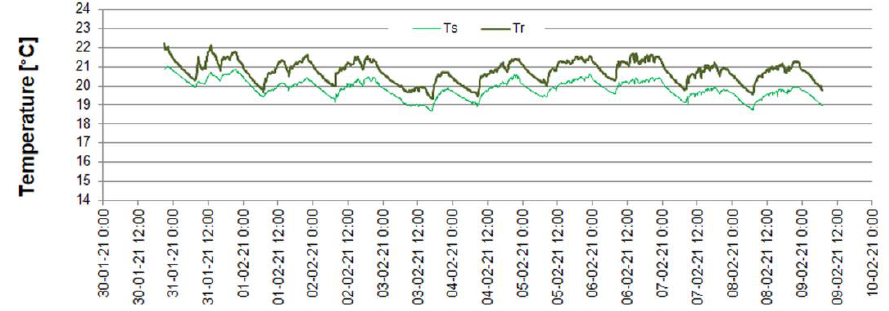
Figure 4. Average wall surface temperature (T s ) and radiative temperature (T r ).